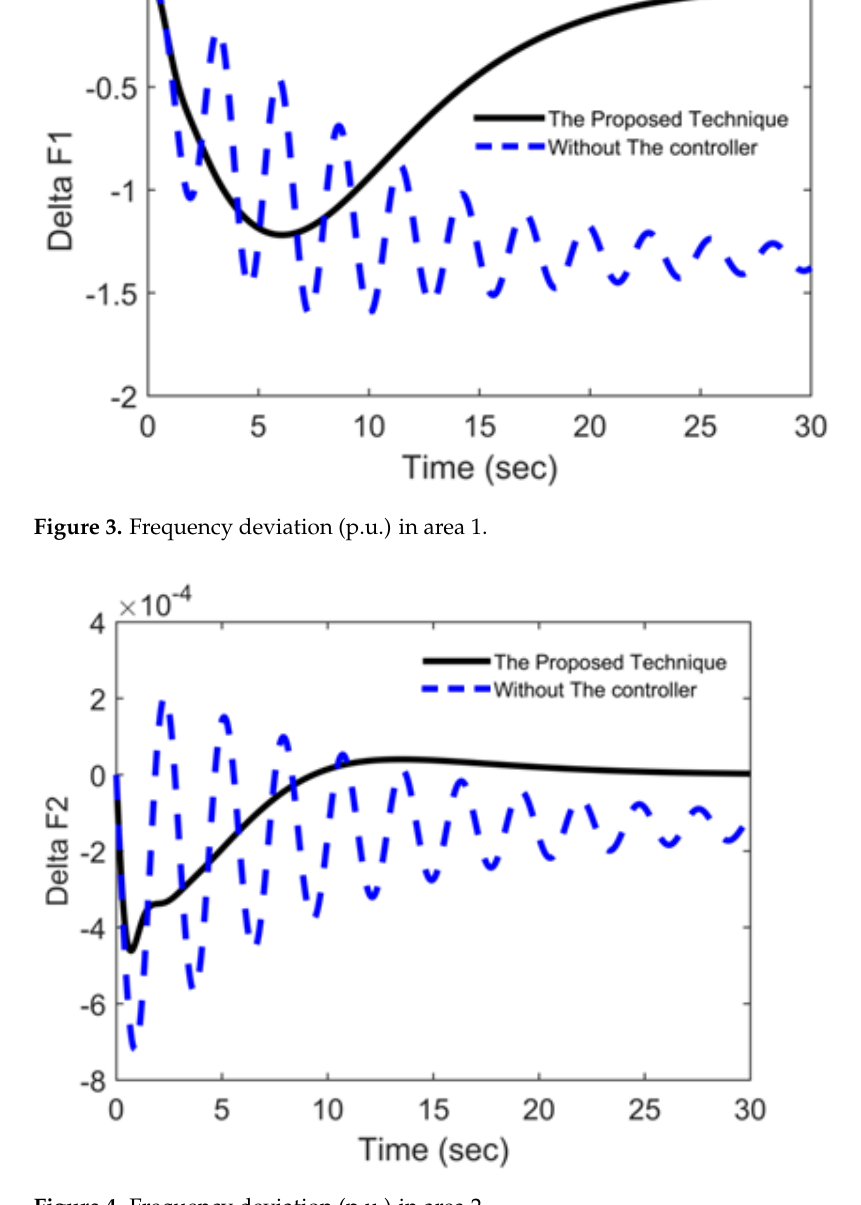
Table 2. The parameters used for the technique presented in [32].